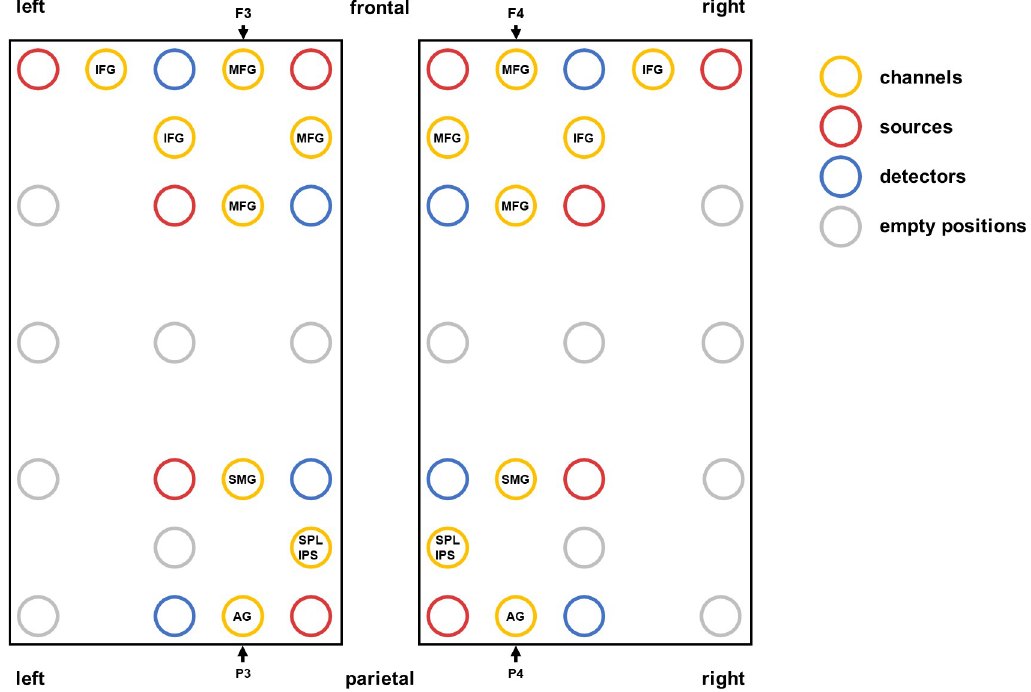
Fig 1. fNIRS probesets covering frontal and parietal areas of the left and right hemisphere. The probesets were fixed at P3/ P4 and oriented towards F3/F4; the positions of channels and optodes (sources and detectors) including empty positions are marked [cf. 25]. Abbreviations of the channel labels : IFG–inferior frontal gyrus, MFG–middle frontal gyrus, SPL/IPS–superior parietal lobule/intraparietal sulcus, SMG–supramarginal gyrus, AG–angular